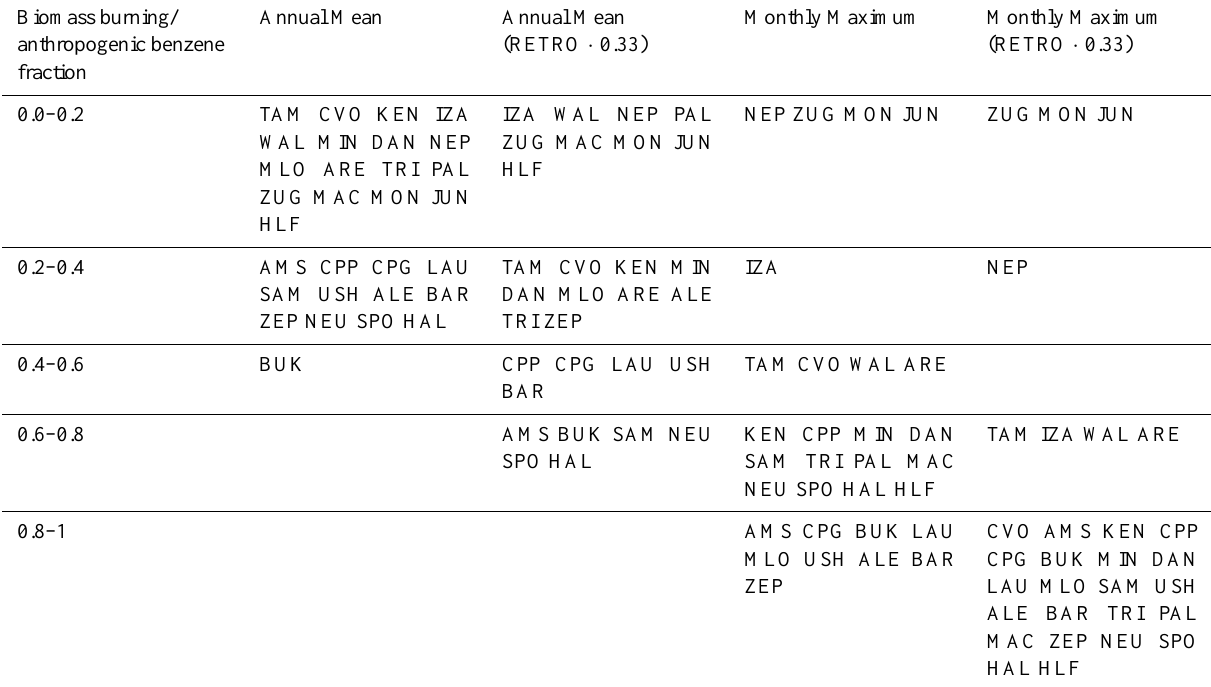
Table 4. GEOS-Chem model estimated fraction of annual benzene associated with biomass burning, given as the annual mean and as the monthly maximum. The anthropogenic emissions used are that of RETRO and 0.33 × RETRO. GAW sites (see Table 3 and Fig. 7) are binned according into which biomass burning fraction range they